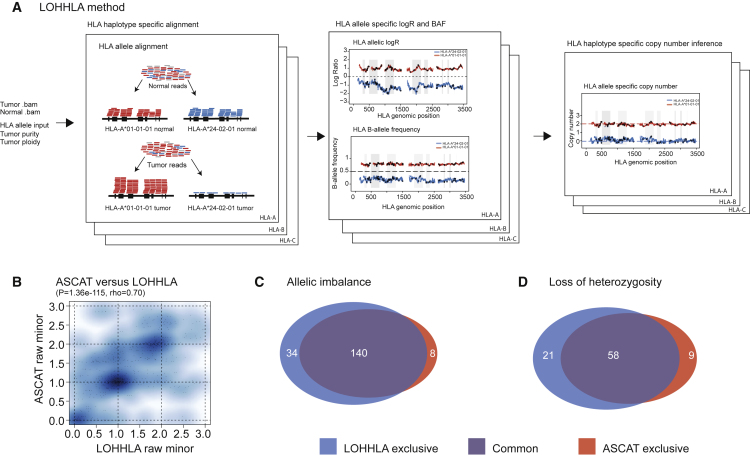
Outline and Validation of LOHHLA for Inference of HLA Class I Allele-Specific Copy Number in Tumors(A) Schematic of the LOHHLA algorithm.(B) Comparison of minor allele copy number for ASCAT and LOHHLA.(C) Venn diagram illustrating LOHHLA and ASCAT comparison for inference of allelic imbalance at HLA locus.(D) Venn diagram illustrating LOHHLA and ASCAT comparison for inference of LOH at HLA locus.See also Figures S1 and S2.